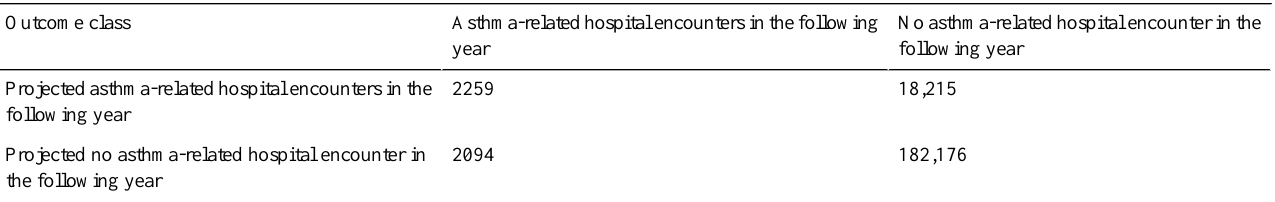
Table 4. The error matrix of our final predictive model when the top 10.00% (20,474/204,744) of patients having the largest predicted risk were adopted as the cutoff point for doing binary